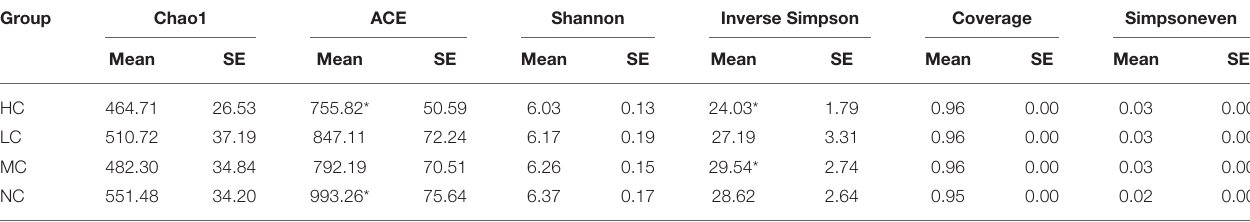
TABLE 1 | Alpha diversity indices for supragingival plaque bacteria in each group at 97% identity. Group Chao1 ACE Shannon Inverse Simpson Coverage